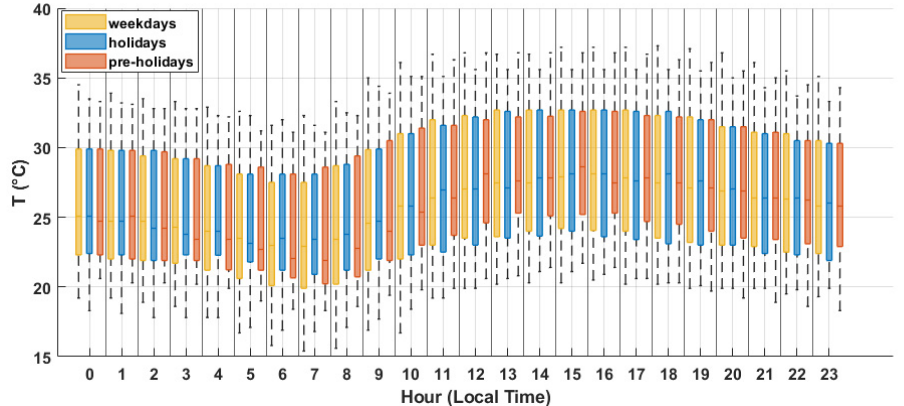
Figure 5. Temperature distribution boxplot in the three months April–June, differentiating among weekdays (orange), pre-holidays (red) and holidays (blue).